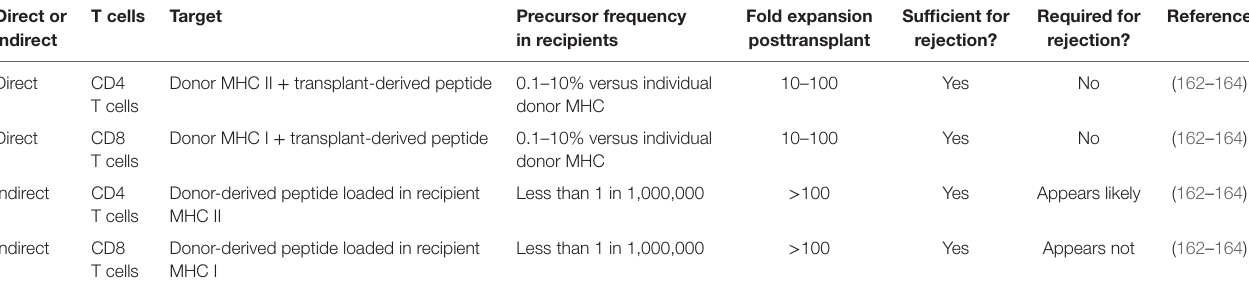
TABle 2 | Islet allograft recognition pathways and likely players in rejection in autoimmune diabetic recipients. Direct or T cells indirect